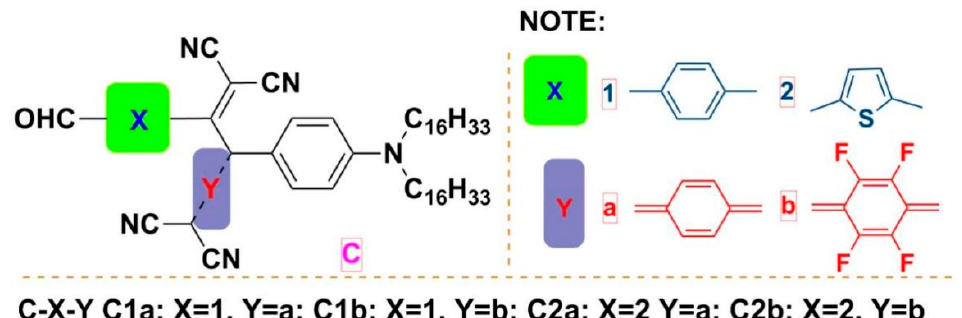
Figure 1. Molecular structures of compounds were named as CXY, X and Y were different modified moieties. modified